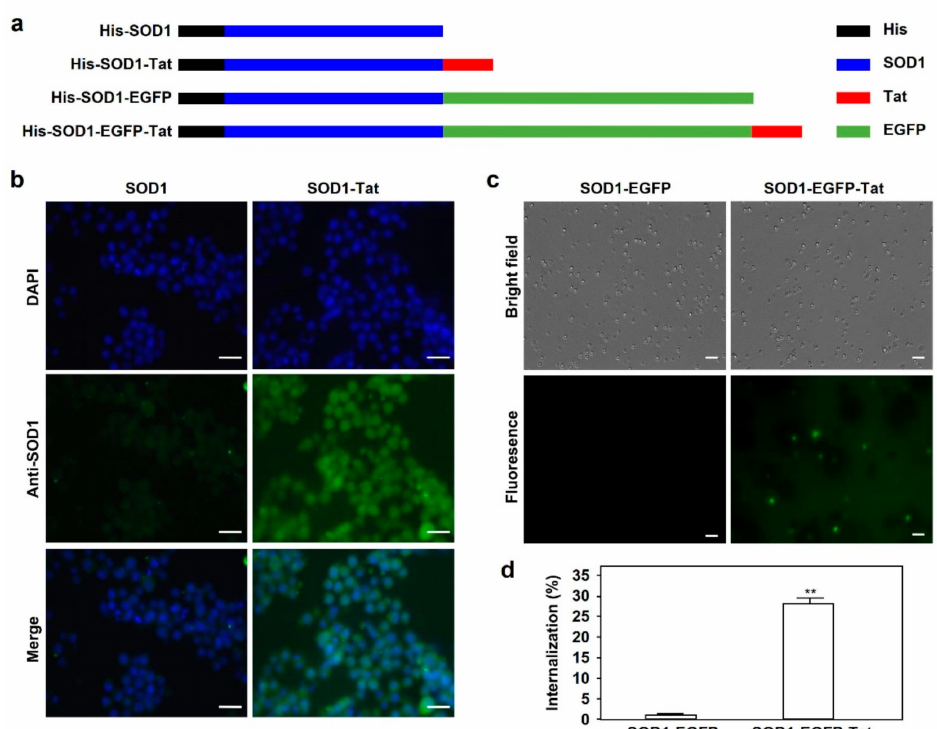
Figure 1. Tat-mediated cell-penetrating activity of SOD1 fusion proteins. ( a ). Schematic structures of His-SOD1, His-SOD1-Tat, His-SOD1-EGFP, and His-SOD1-EGFP-Tat fusion proteins expressed in the Rosetta 2(DE 3 ) strain of E. coli. ( b ). Tat-mediated cell penetration of SOD1 fusion proteins in RAW264.7 cells. RAW264.7 cells were incubated with 5 µ M SOD1 or SOD1-Tat fusion protein at 37 ◦ C for 1 h. After incubation with a specific anti-SOD1 antibody and the corresponding secondary antibody, the cells were observed for protein internalization by fluorescence microscopy. Bars represent the length of 40 µ M. ( c ). Tat-mediated cell penetration of SOD1 fusion proteins in bone marrow cells. Bone marrow cells were isolated from mouse femurs and incubated with 5 µ M SOD1- EGFP or SOD1-EGFP-Tat fusion protein at 37 ◦ C for 1 h. Tat-mediated protein internalization was examined by fluorescence microscopy. Bars represent the length of 20 µ M. ( d ). Quantitative analysis of Tat fusion protein internalization in bone marrow cells. The percentage of EGFP-positive cells in Figure 1c was calculated under a fluorescence microscope. Data are shown as mean ± SD and represent three independent experiments ( n = 3). **: p < 0.01, versus SOD1-EGFP